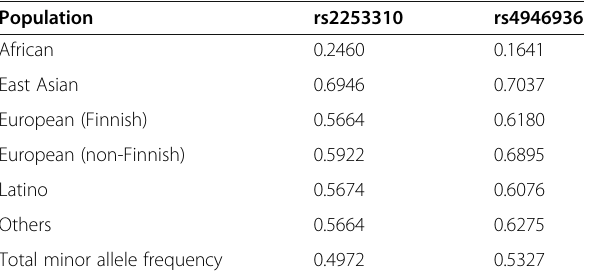
Table 3 Minor allele frequency of SNVs in different